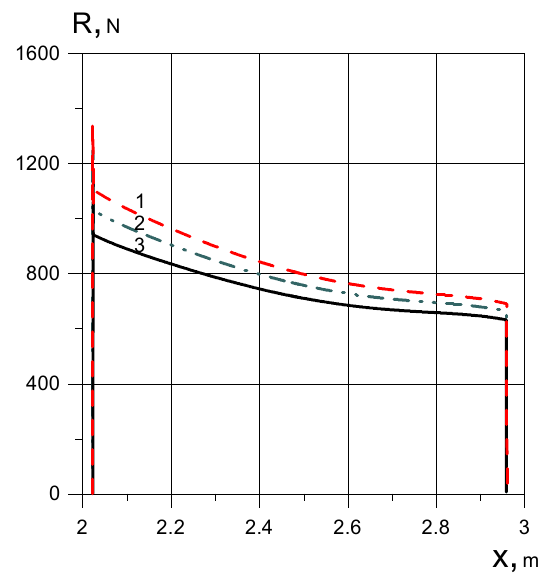
Figure 6 – Calculated values of the reaction R of the guide at the point of contact along the length of the section x of the spatial movement of the projectile at different